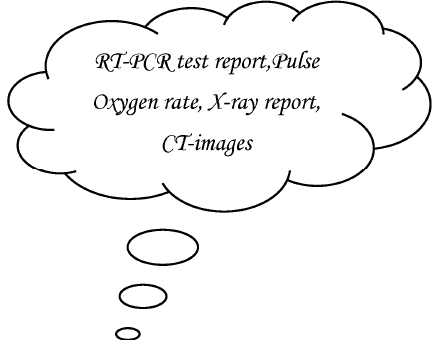
Figure 5. Google Cloud storage for the proposed IoMT system.